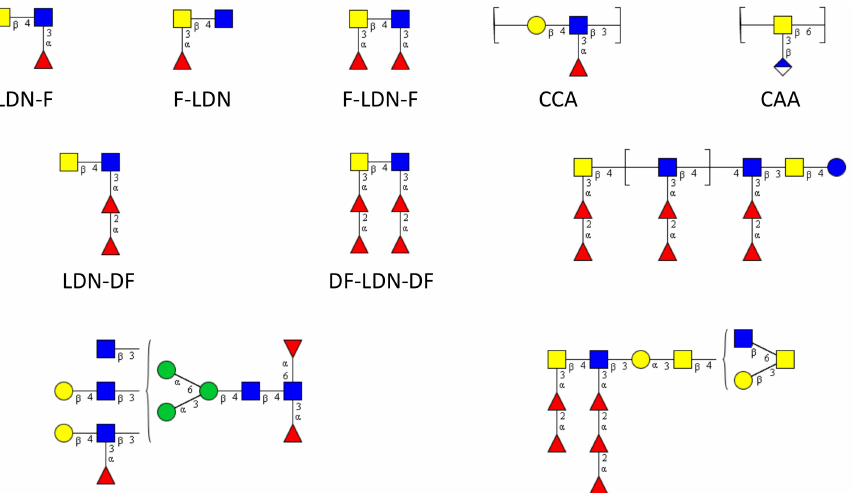
Figure 1. Overview of several observed glycans in S. mansoni . Red triangles: L -Fucose, blue square: D -GlcNAc, yellow square: D -GalNAc, blue circle: D -Glucose, yellow circle: D -Galactose, green circle: D -Mannose, and blue/white diamond: D -Glucuronic acid